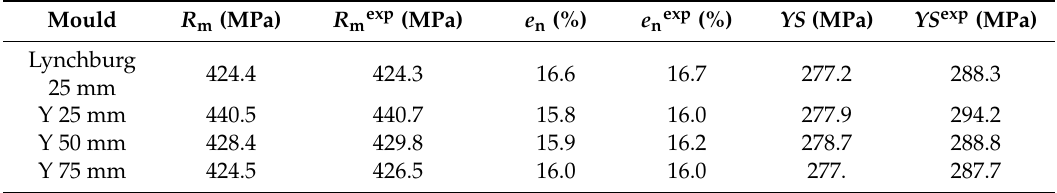
Figure 5. Engineering stress–strain flow curves (up to ultimate tensile stress R m ) built with the average microstructure parameters for the four different moulds reported in Table 2. Table 3. Comparison between the predicted (engineering flow curves reported in Figure 5) and experimental ( exp ) average tensile properties, ultimate tensile strength R m , yield stress YS , and elongation at necking e n .